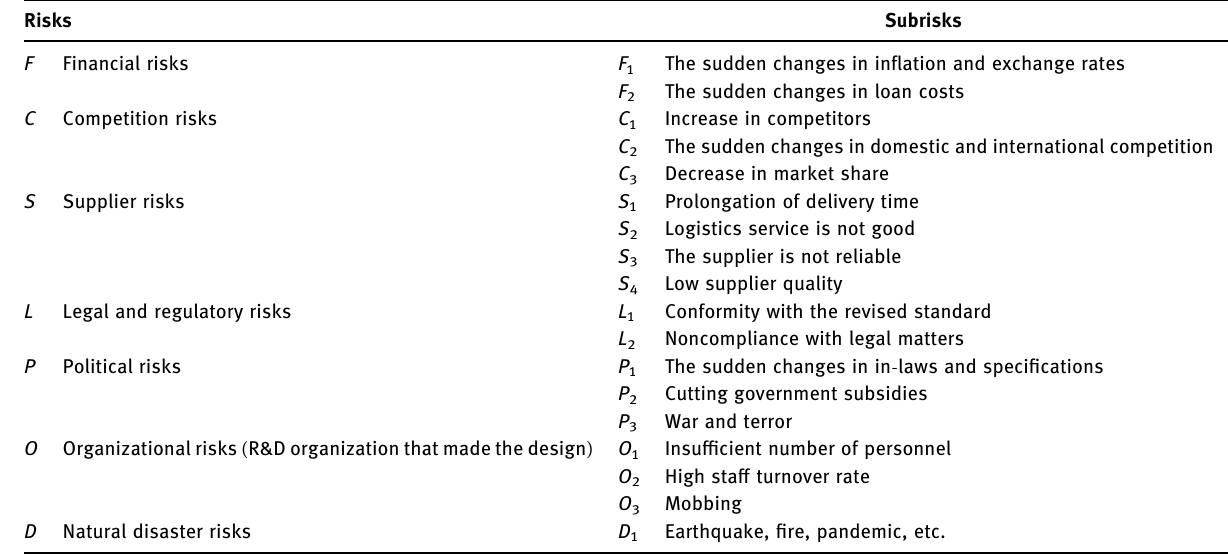
Table 4: External risks were a ff ecting the product development process